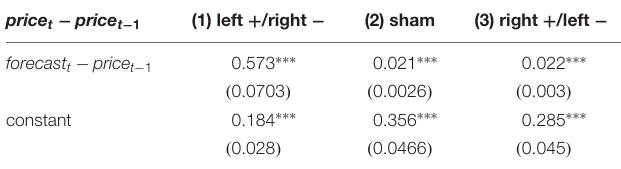
TABLE 2 | Regression on price